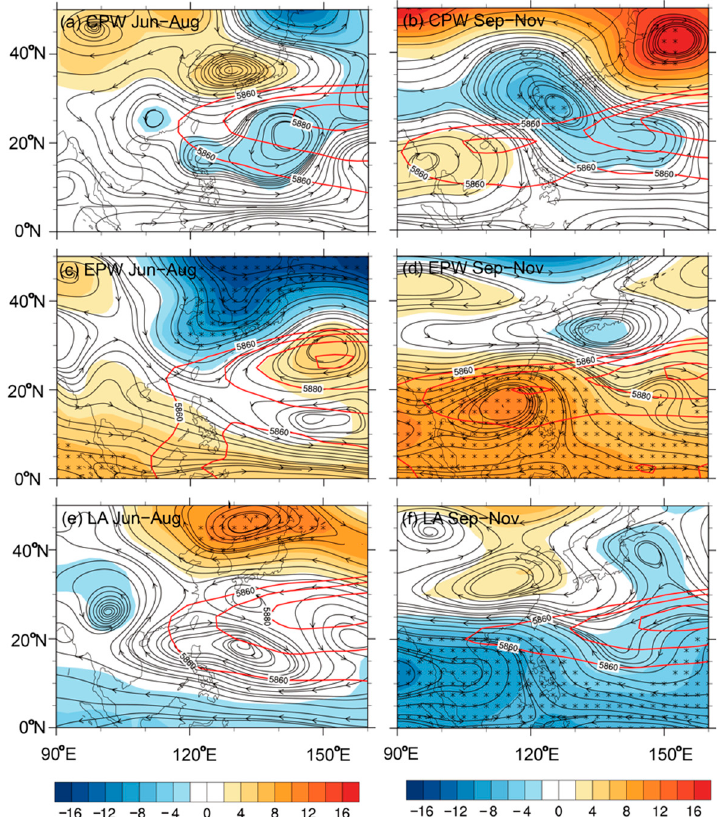
Figure 10. Composite anomalies of the steering flow (streamline, m/s) and subtropical high (red contour, gpm) at 500 hPa for JJA ( a , c , e ) and SON ( b , d , f ) seasons during CPW ( a , b ), EPW ( c , d ) and LA ( e , f ) events. Regions with trends that are significant at 90% confidence are shaded by dots. The inter-annual variation of the vertical wind shear (VWS) causes different TC activities in different ENSO phases. The VWS is calculated as the magnitude of the vector difference between winds at 200 and 850 hPa. Strong VWS inhibits the formation and development of TCs, while weak VWS promotes TC activities [53]. Figure 11 displays the distribution of VWS for each of the three regimes in different seasons. For CPW years, the reduction of VWS over the China coastal area and the offshore area contributed to the enhancement of landfalling TC activities in the summer [36], allowing landfalling TCs passage through the weak shear region across the east coast of China. In the SON for CPW years, there was a mirror image of VWS distribution in the JJA. In an EPW event, there were almost positive anomalies in summer and autumn over the China coastal area and adjacent sea area, depressing TC development when they were approaching and making landfall. The distribution of VWS in LA years provided a mirror image of the EPW years, which offered more favorable conditions for landfalling TCs with negative anomalies over China, especially in autumn, resulting in stronger TCs making landfall in autumn.